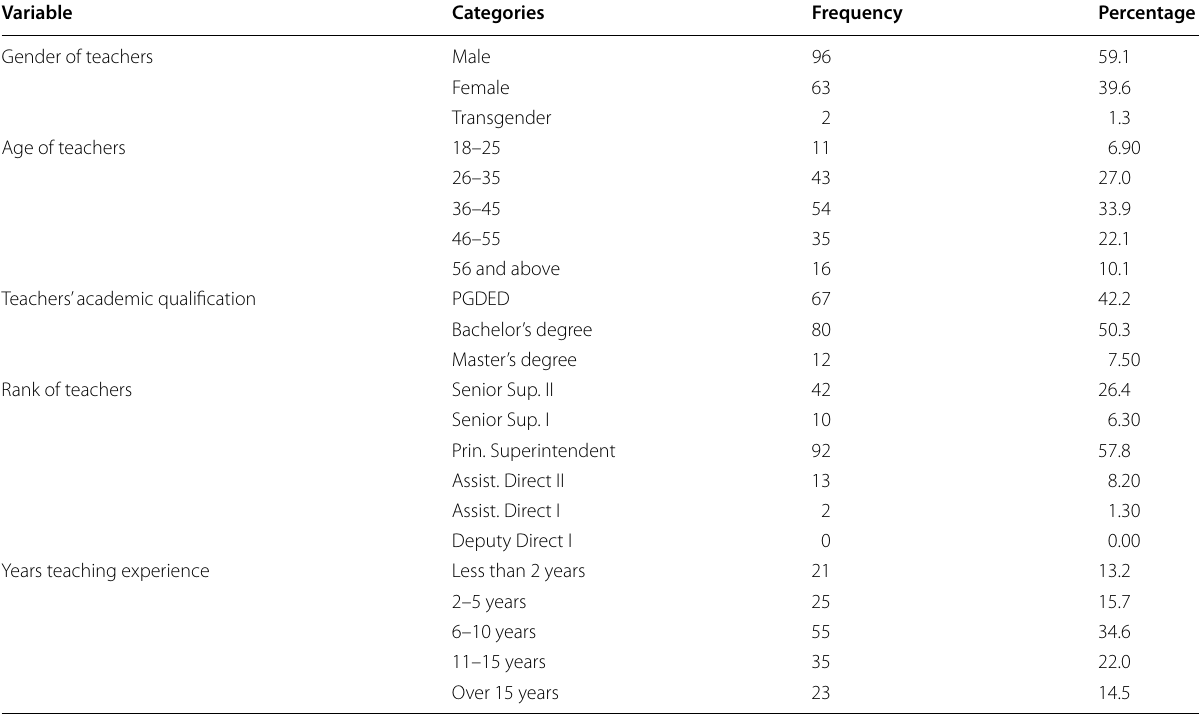
Table 1 Demographic characteristics of the teacher participants (total Questionnaire (2019)